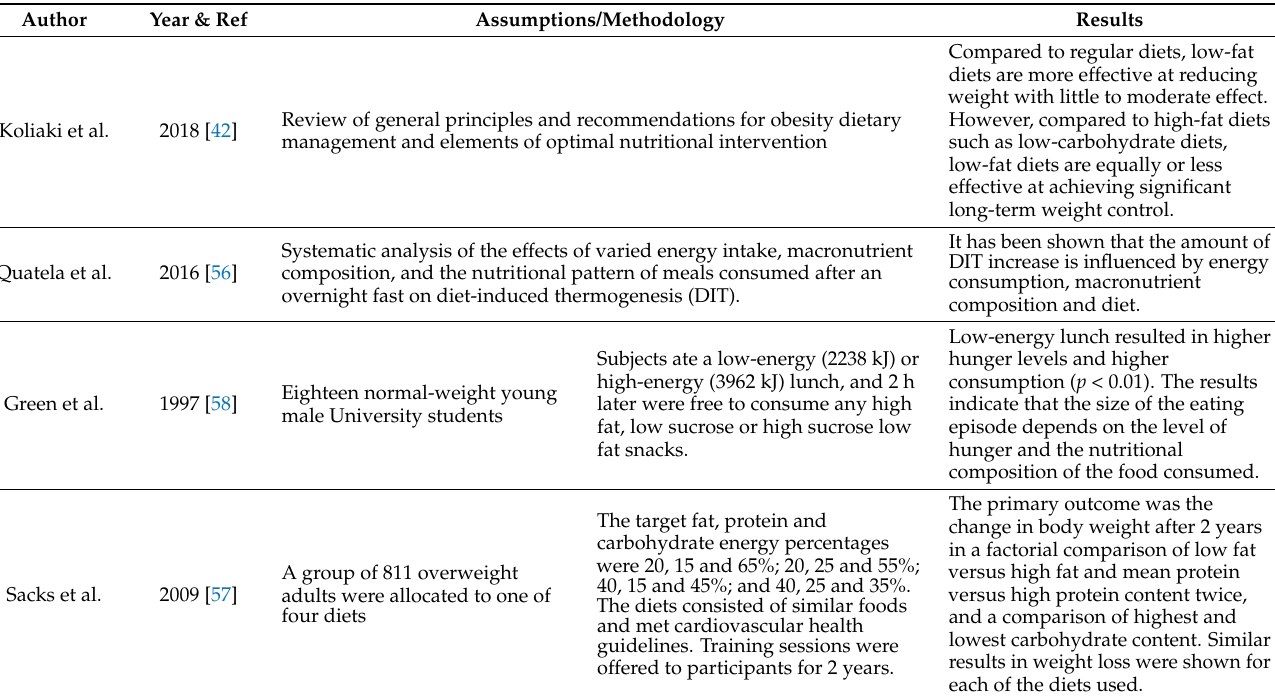
Table 3. Effects of Low saturated fat weight-loss